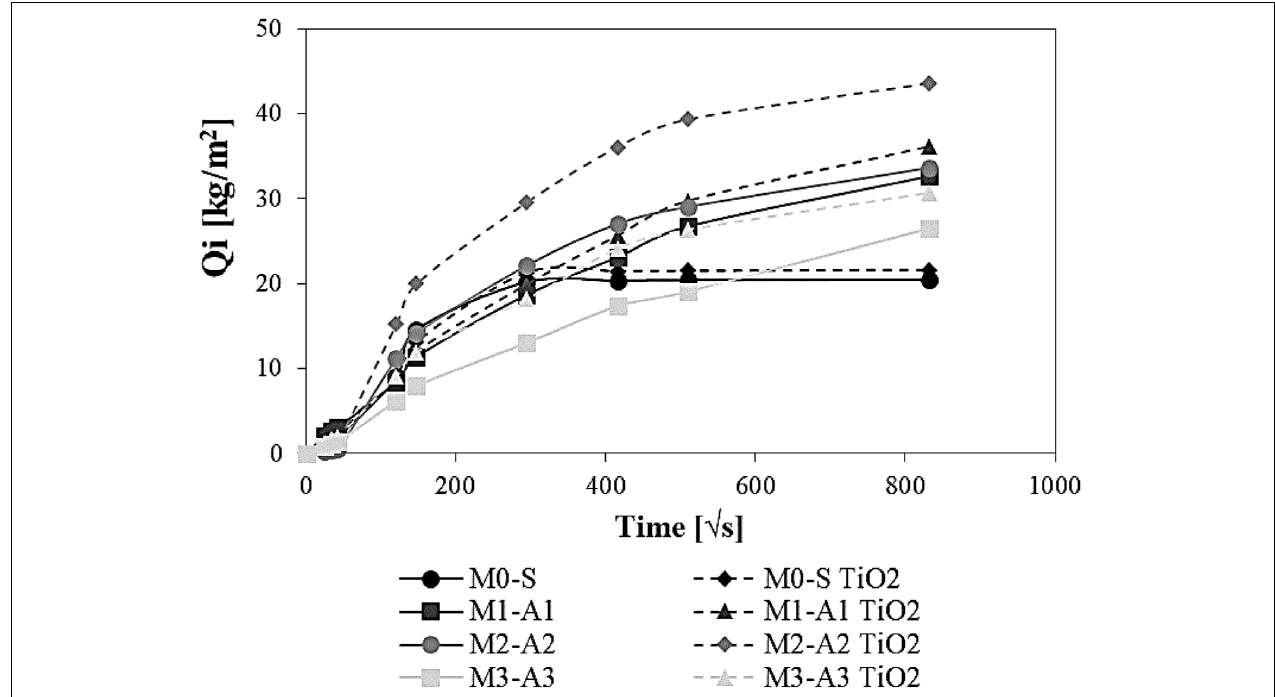
FIGURE 5 | Capillary water absorption in time of hydraulic lime-based mortars.